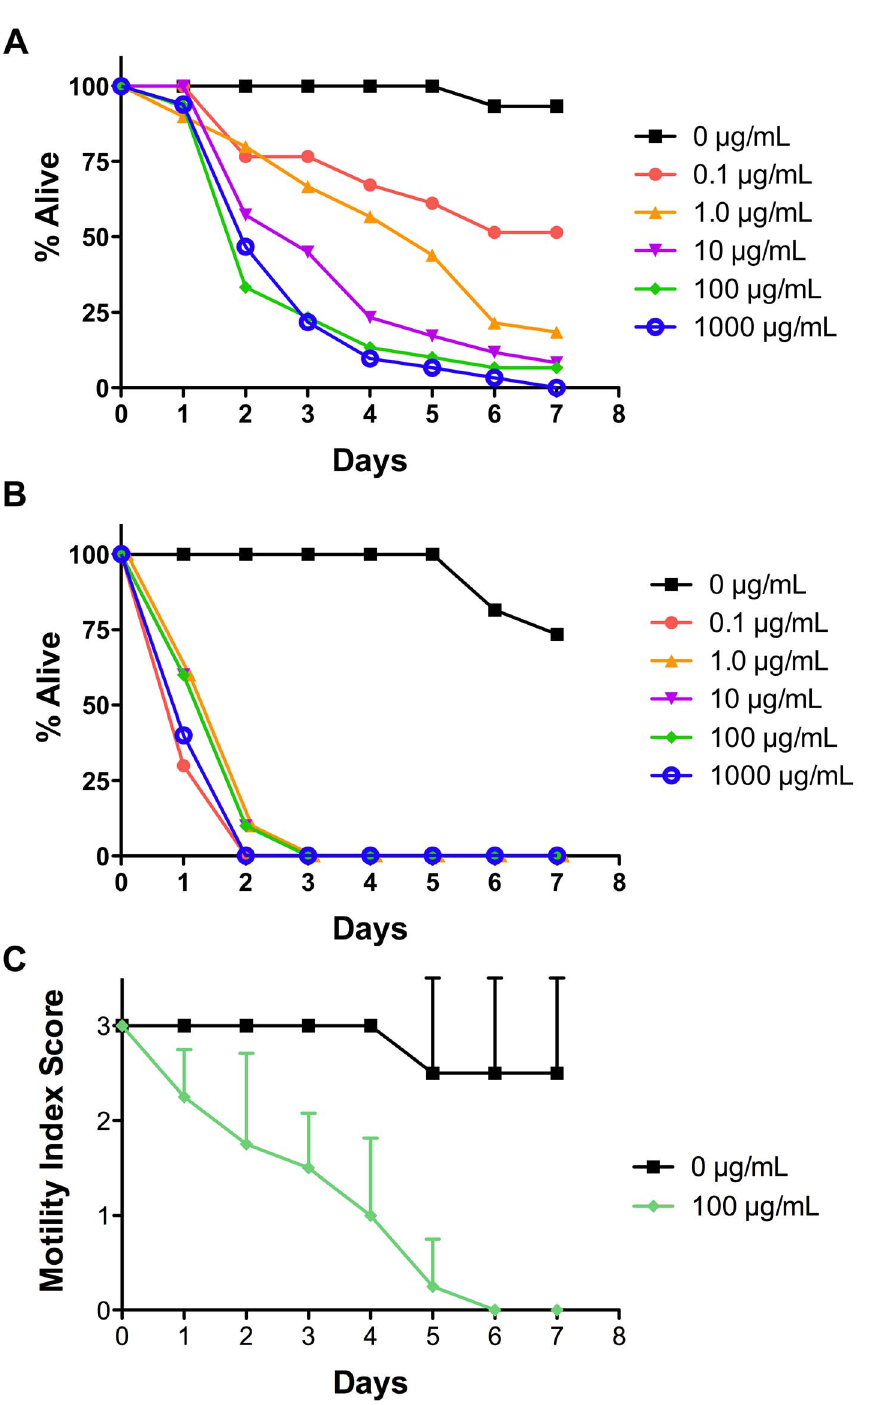
Figure 2. Ascarissuum larvae and adults are susceptible to Cry5B invitro . A. The % live (motile) day 14 post-inoculation (PI) fourth-stage larvae (L4) scored on a daily basis at various doses of Cry5B (three trials combined as one); n=30–36/condition. Legend indicates the dose of Cry5B. B. The % live (motile) day 19 PI L4 scored on a daily basis at various doses of Cry5B (two trials combined as one); n=20–24/condition C. Average motility index score of adults exposed to 100 m g/mL Cry5B (days 54 and 89 PI combined as one) scored on a daily basis. Motility index is as defined in Methods. Error bars indicate standard deviation. n=4/condition.